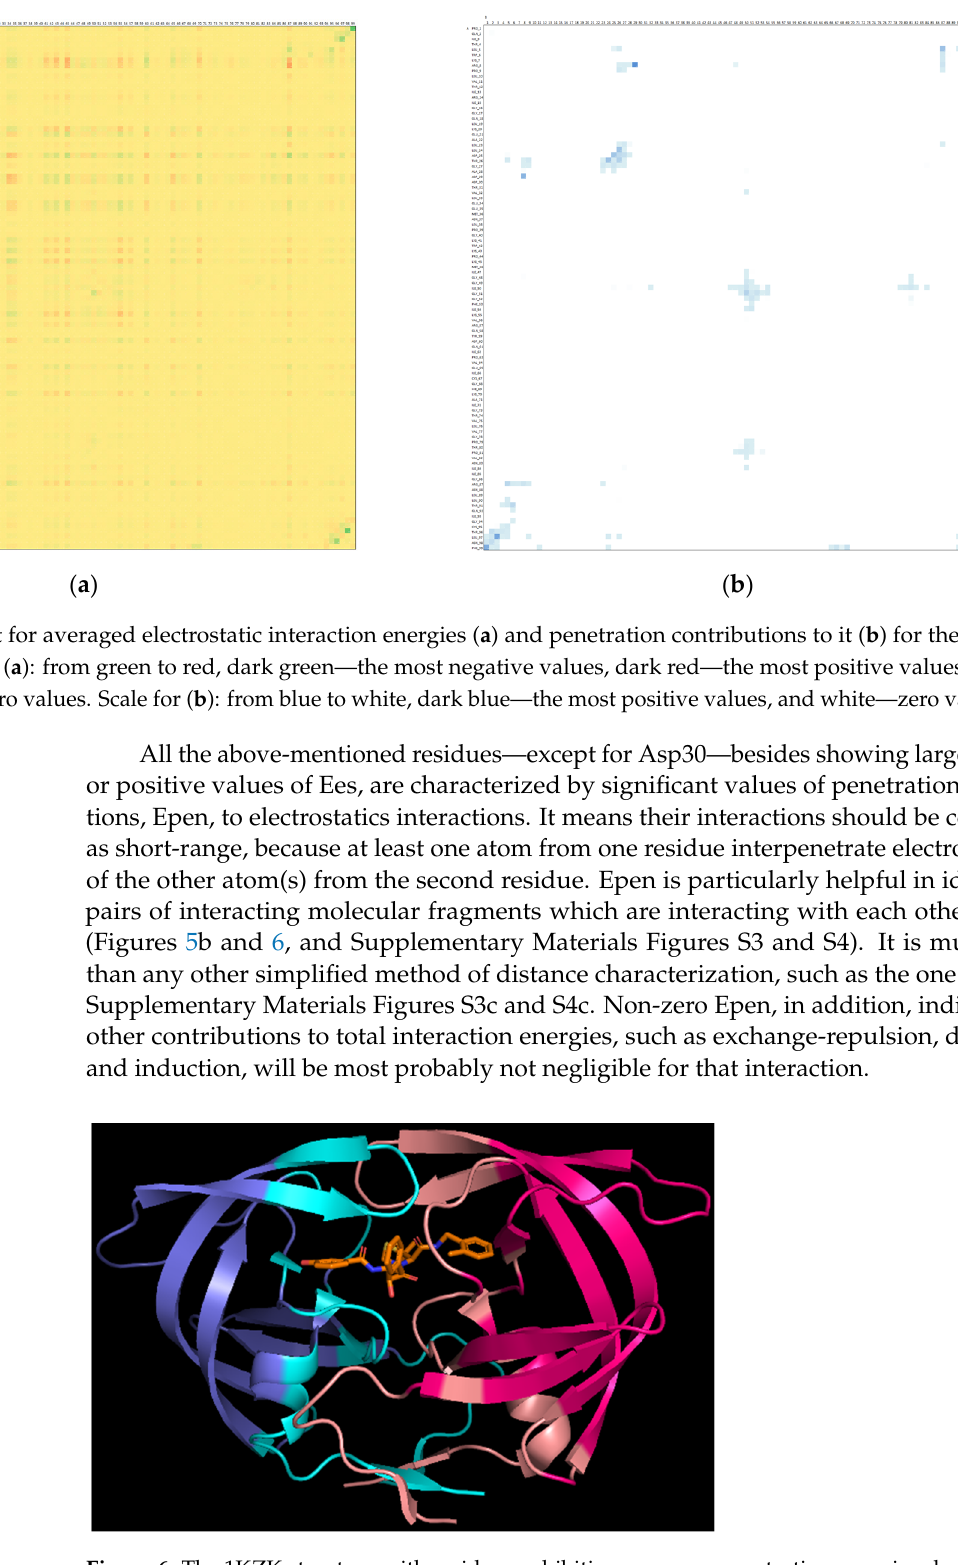
Figure 6. The 1KZK structure with residues exhibiting non-zero penetration energies shown in light blue (monomer A) and light red (monomer B).